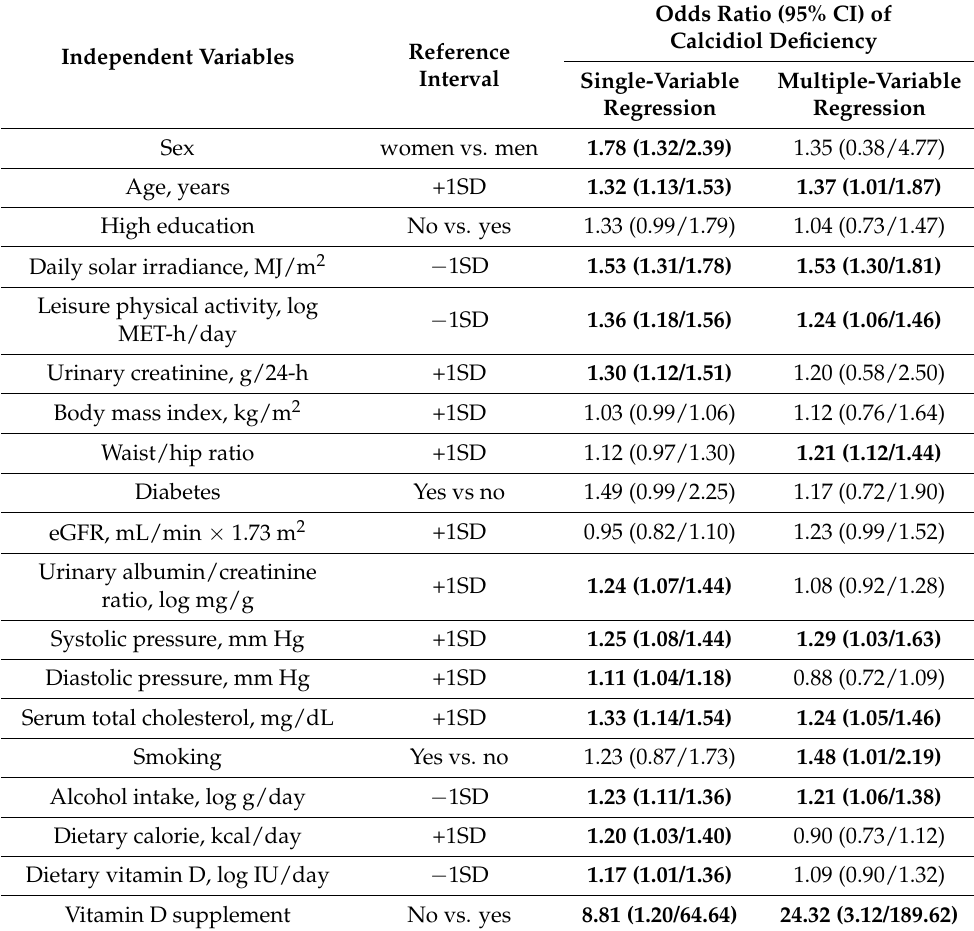
Table 3. Odds ratio (95% CI) of calcidiol deficiency in single-variable and multiple-variable logis- tic regression.